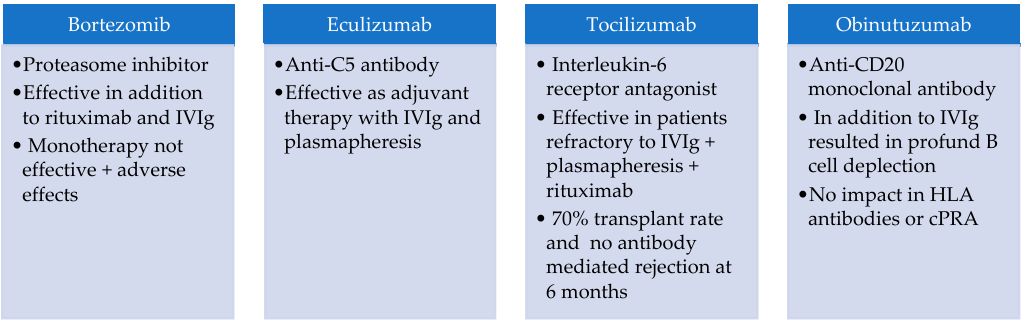
Figure 3. New drugs with potential benefits on dessensitization on small RCT [77–82]. Imlifidase, a recombinant cysteine protease derived from Streptococcus pyogenes ,